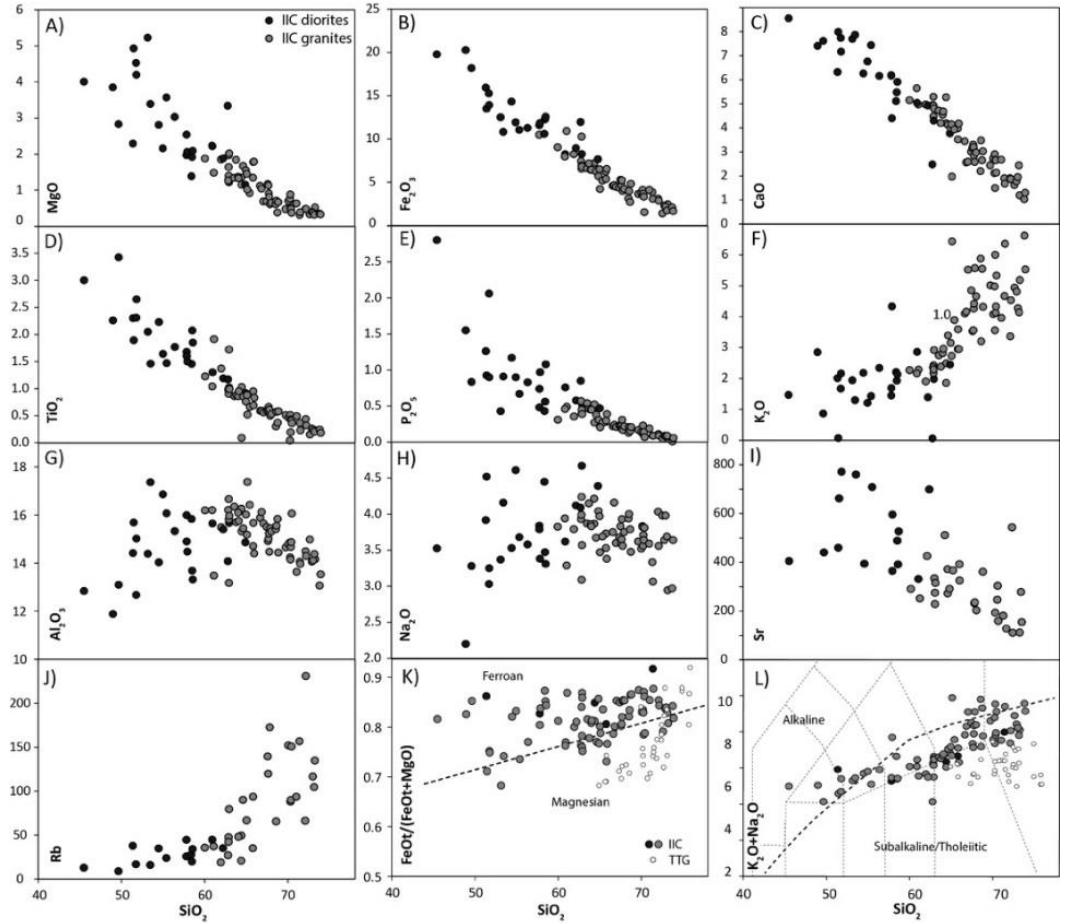
Figure 4. Major element chemistry plotted in Haker diagrams. It can be noticed that MgO, Fe 2 O 3